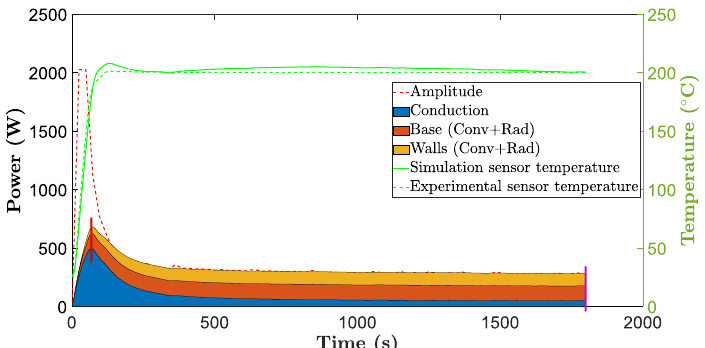
Figure 8. Representation of the heat losses of computational Model II of the WMF (coloured areas), the amplitude of the power density introduced (red dotted line) and the experimental and simulation sensor temperatures (dotted and continuous green lines, respectively). The blue area corresponds to conduction losses between the base of the pan and the glass. The orange and yellow areas indicate the convection and radiation losses in the base and walls of the pan, respectively.